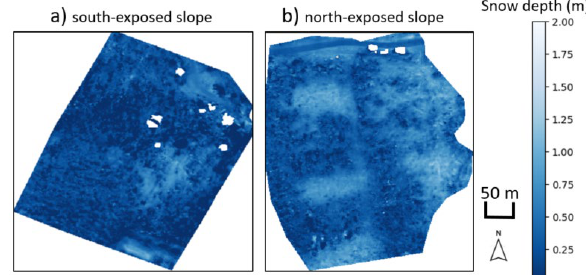
Figure 4 . Snow depth maps for the south (a) and north (b) exposed steep slopes.